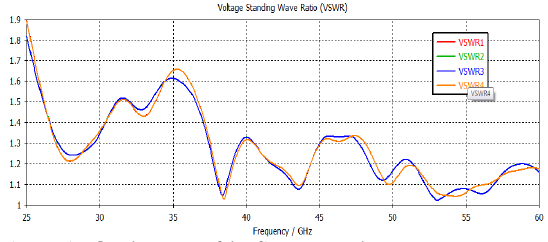
Fig10. Simulated VSWR of the first proposed MIMO 2X2 antenna .